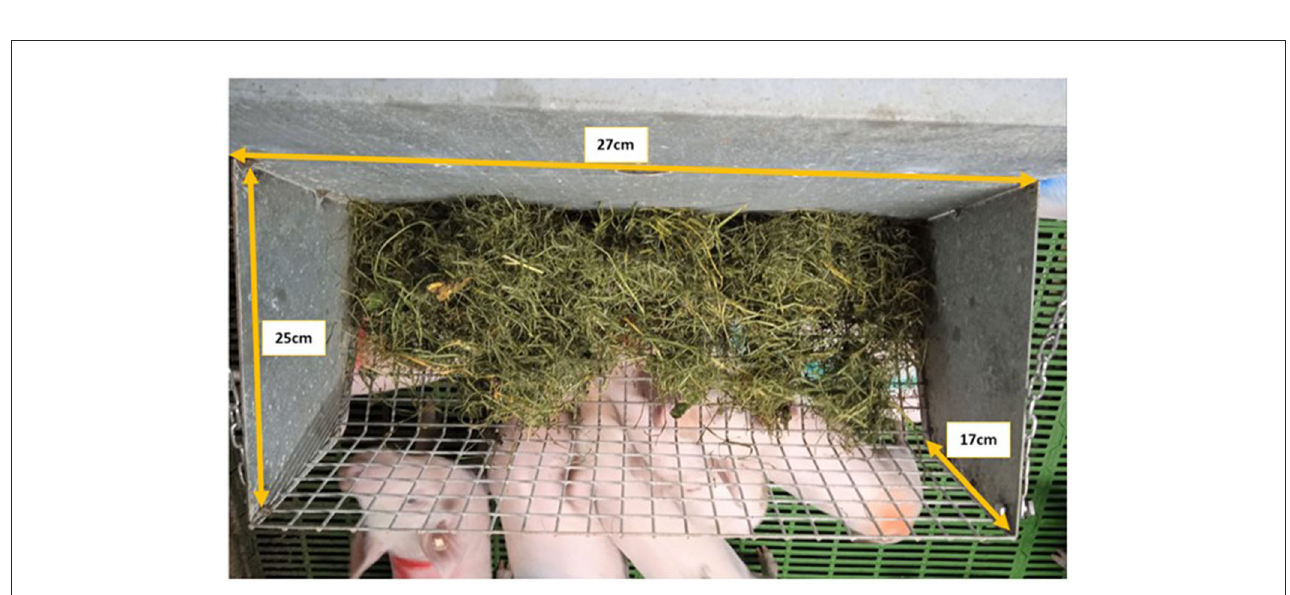
FIGURE2 Rack dimensions (27cm × 25cm × 17cm) for grass enrichment used from weaner to finisher stage for both SINGLE and DOUBLE.